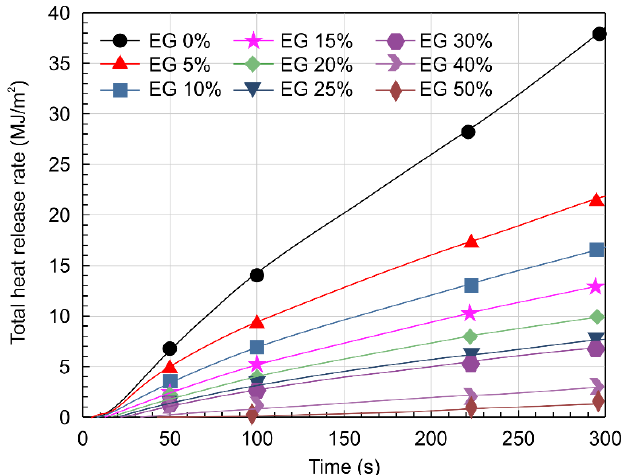
Figure 10. Variation in total heat released (THR) with combustion time.